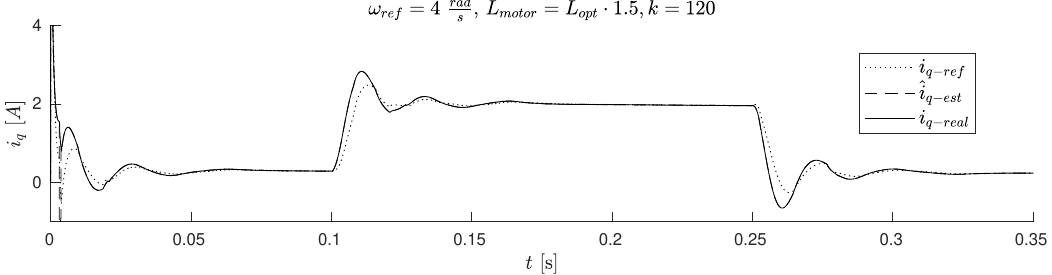
ˆ i q est , and measured i q ref , estimated − −